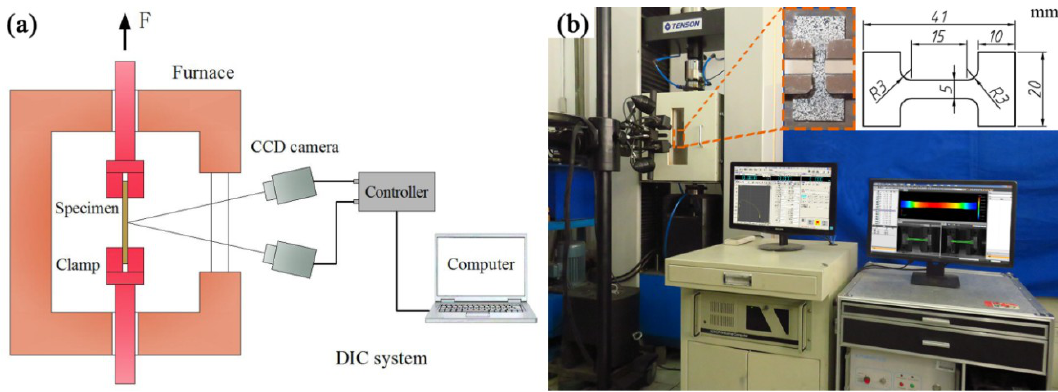
Figure 1b. The crosshead speeds were set as 0.9, 9, and 90 mm/min, which represented the nominal initial strain rates of 0.001, 0.01, and 0.1 s − 1 , respectively. After the furnace reached the set temperature, the specimens were fixed on the clamp and held for 20 min to gain a uniform temperature distribution before tensile tests. To obtain the strain distribution, a white under coating was painted on the sample to enhance the image contrast when preparing the speckles. However, it fell off easily under large deformation at high temperatures, resulting in the failure of strain measurement. Thus, a dull finish was adopted instead of the white under coating. After that, the DIC specimen was prepared by painting black speckles on the specimen with heat-resistant paint.